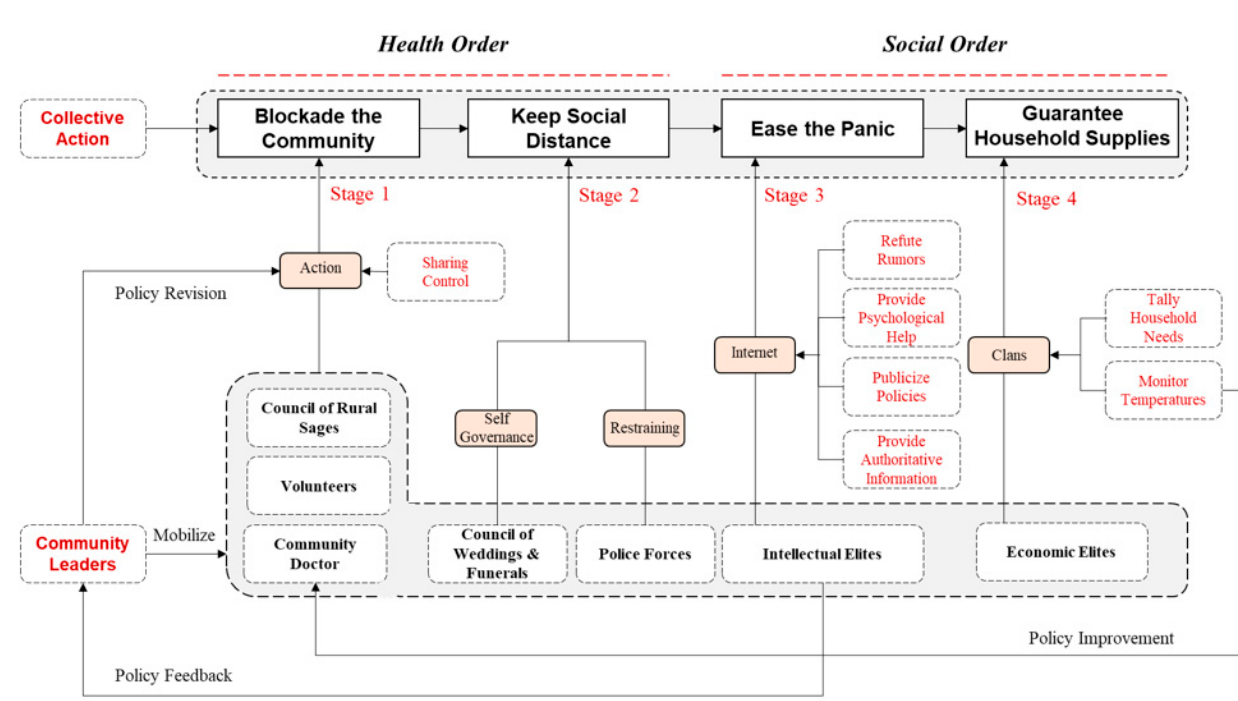
Figure 4. Collaborative efforts in community anti-epidemic actions in